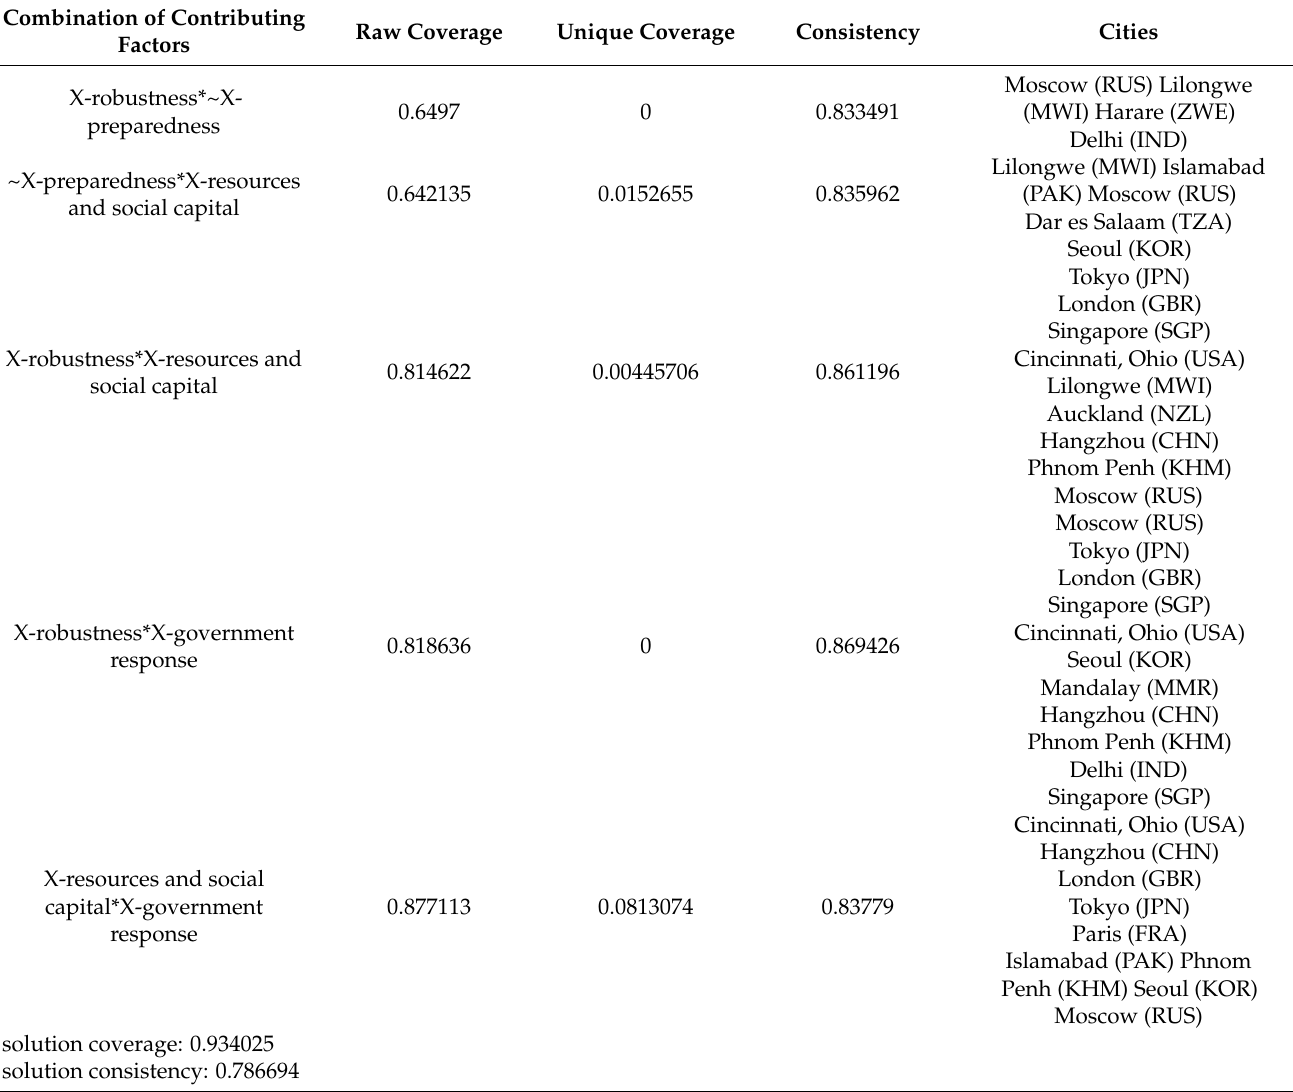
Table 8. fsQCA outcomes of the combination of